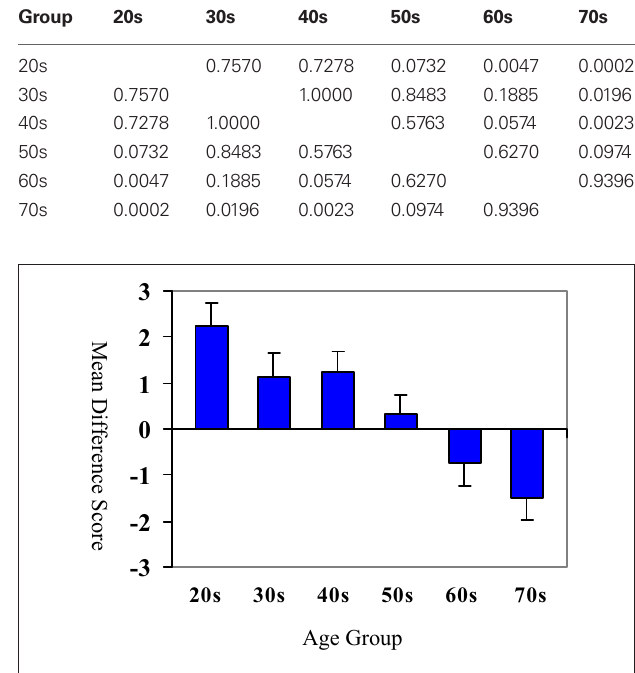
Figure 2 | Difference score by age group: neutral inhibition–emotion inhibition. Bars represent means of neutral inhibition–emotional inhibition difference score (i.e., the difference between the number of correct responses on the neutral inhibition task and the emotional inhibition task). Age groups are on the x axis. Note the change in sign in the difference score in the 60- and 70-year-old age groups as this demonstrates that older participants had more correct responses on the emotional inhibition task relative to the neutral inhibition task This pattern of performance is indicative of a decreased susceptibility to emotional stimuli among older adults and increased susceptibility to emotional stimuli in younger adults.